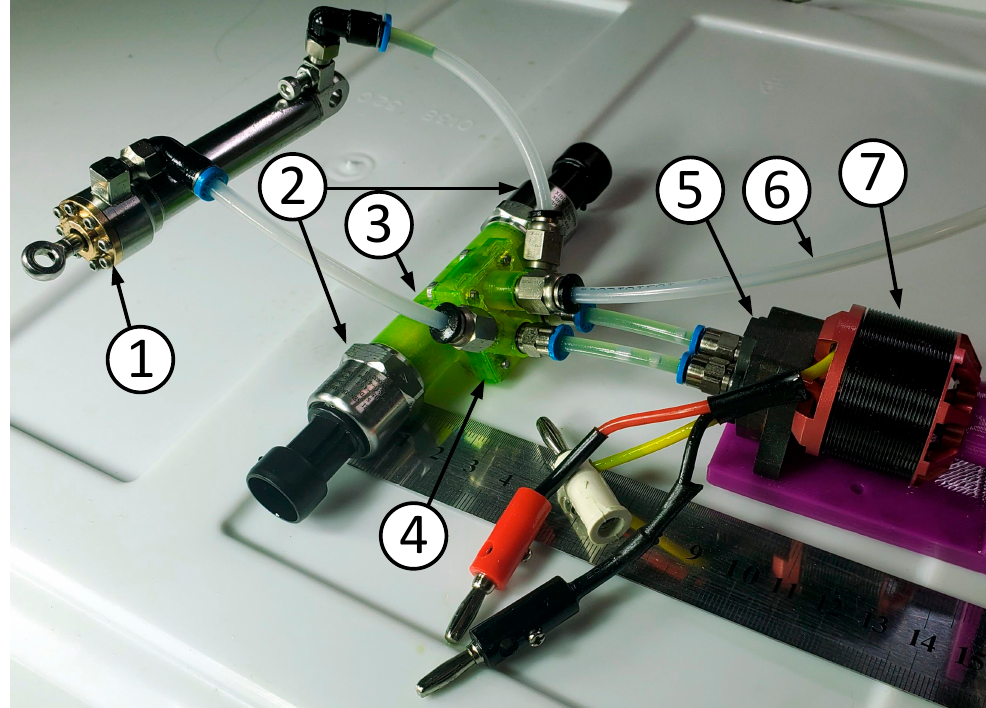
Figure 3. Photos of system, including ( 1 ) hydraulic cylinder, ( 2 ) pressure transducers, ( 3 ) 3D-printed valve, ( 4 ) mounting plate, ( 5 ) pump, ( 6 ) charge pump line, and ( 7 ) motor. A cm ruler is included for scale.